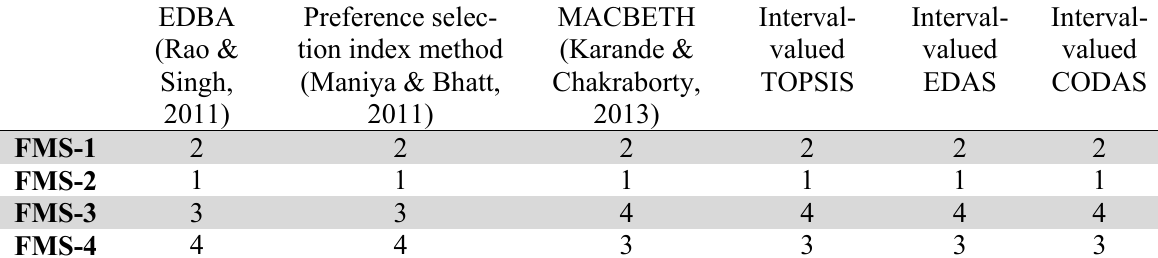
Comparison of ranking for FMS using various MCDM